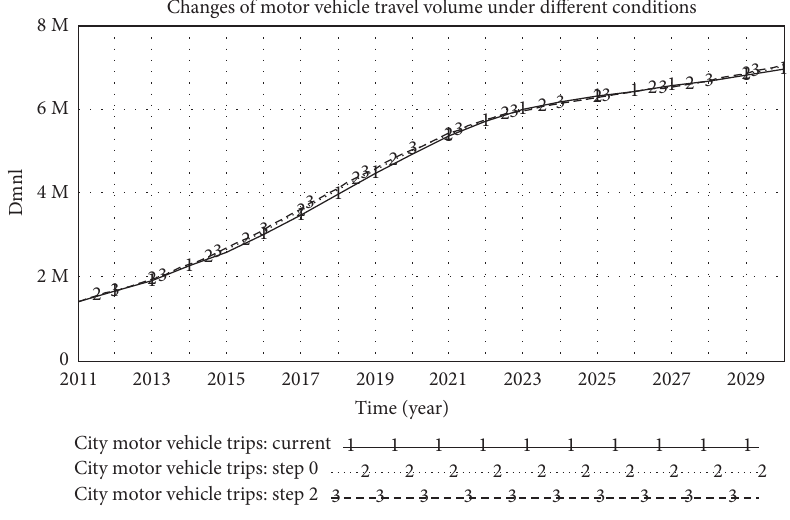
Figure 6: Historical